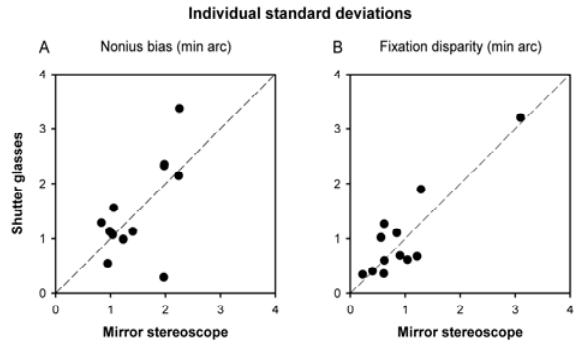
Figure 5. Comparison of shutter glasses and mirror stereo- scope for the intra-individual standard deviations of 12 subjects for the nonius bias (A) and the fixation disparity